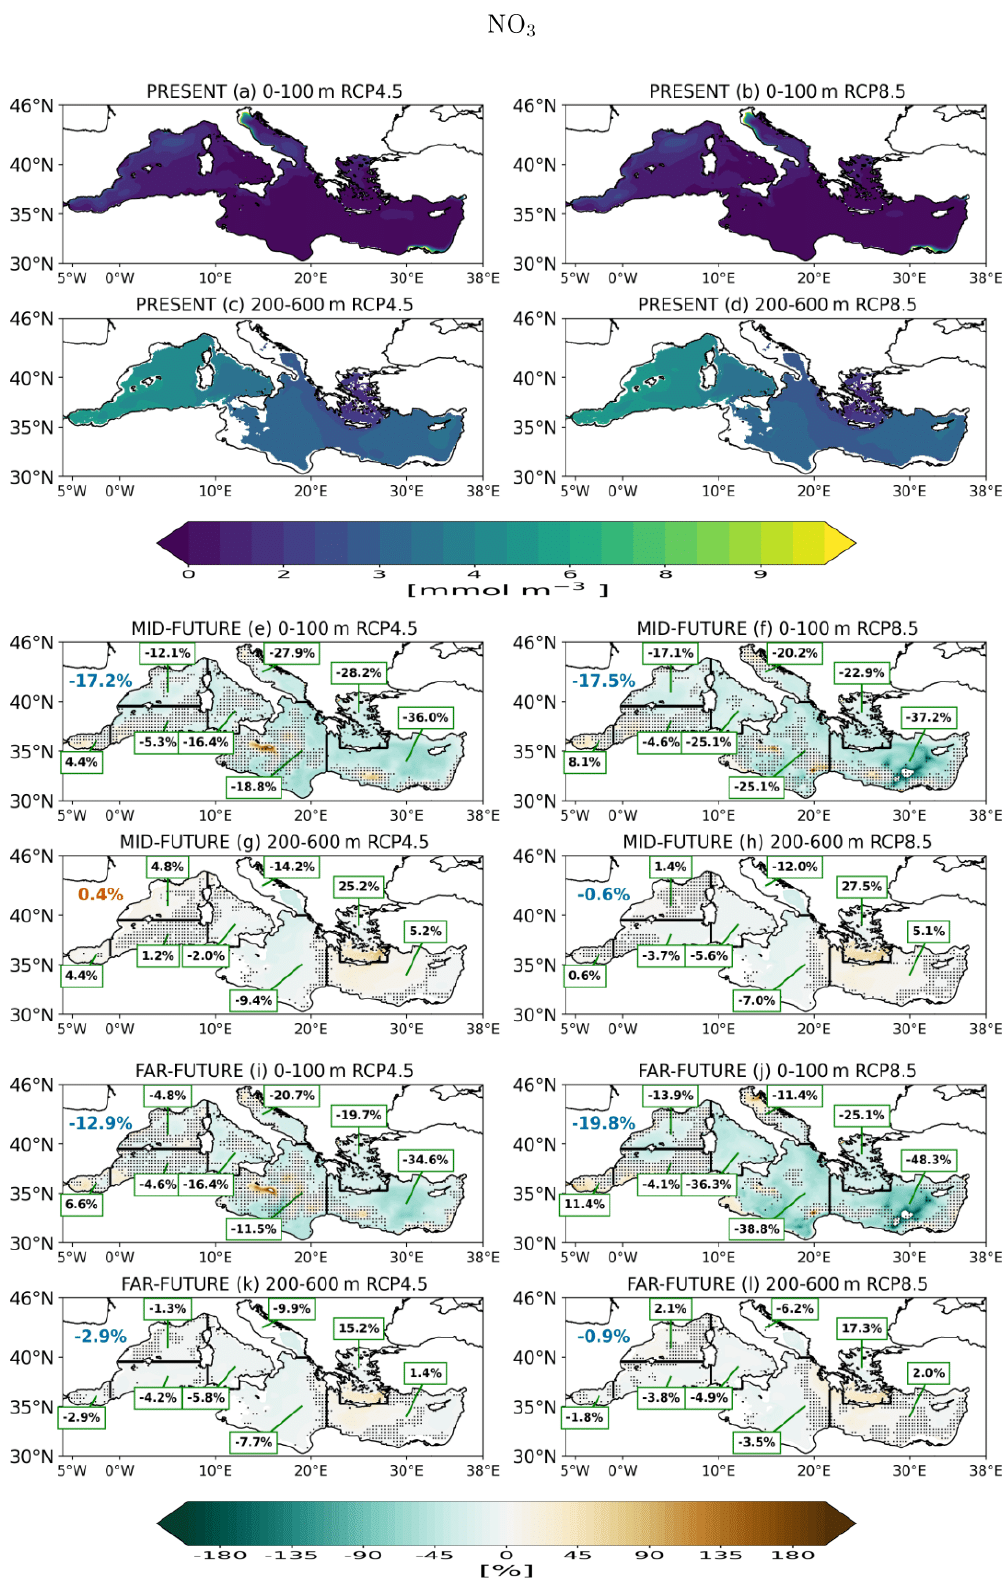
Figure 6. As Fig. 5, but for nitrate (in mmolm − 3 ).